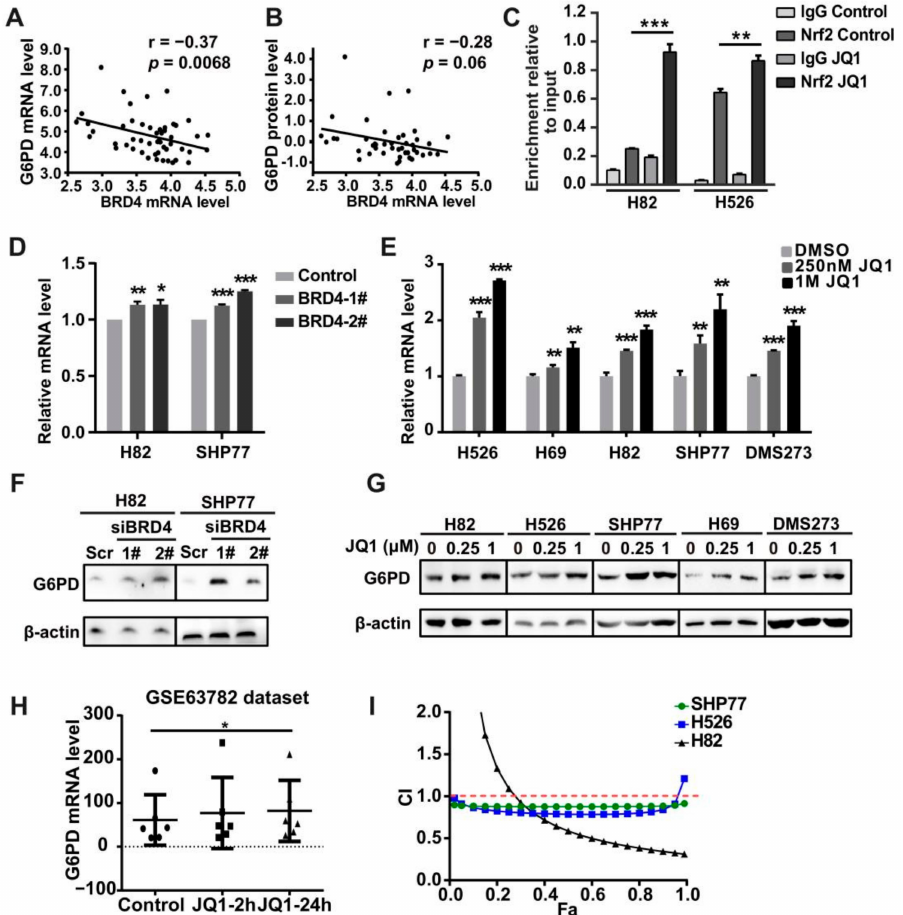
Figure 5. Nrf2 transcriptionally regulates G6PD in SCLC cells. ( A , B ) Scatter plots showing the correlation between BRD4 expression and the expression of G6PD at mRNA ( A ) and protein ( B ) levels. ( C ) ChIP-qRT-PCR experiment indicating the direct binding of Nrf2 to the G6PD promoter in H82 and H526 cells after 48 h exposure to JQ1 or 0.01% DMSO (vehicle). ( D , E ) RT-qPCR analysis of G6PD upon BRD4 silencing ( D ) in H82 and SHP77 cells and JQ1 treatment ( E ) in five SCLC cell lines. ( F , G ) Western blot analysis of G6PD upon BRD4 silencing ( F ) in H82 and SHP77 cells and JQ1 treatment ( G ) in five SCLC cell lines. ( H ) Scatter plots showing G6PD expression upon JQ1 treatment based on the GSE63782 dataset. ( I ) CellTiter-Glo Luminescent assays demonstrating the synergistic effects of the combination of RRx-001 and JQ1 in H82, SHP77, and H526 cells. * p < 0.05; ** p < 0.01; *** p < 0.001 (Student’s t